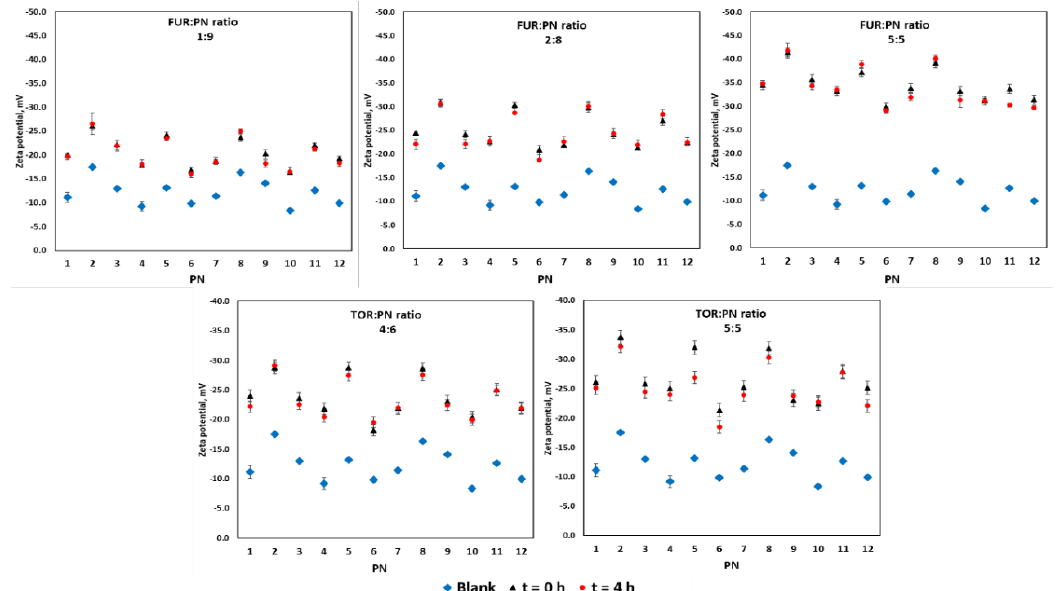
Figure 3. The zeta potential values of drug–PN samples upon preparation and 4 h later (black and red signs), and PN upon preparation (blue signs). The upper part refers to FUR:PN samples in three different ratios, whereas the down part refers to TOR:PN samples in two ratios. FUR, furosemide; PN, parenteral nutrition admixture; TOR, torsemide; Blank, PN without drug.